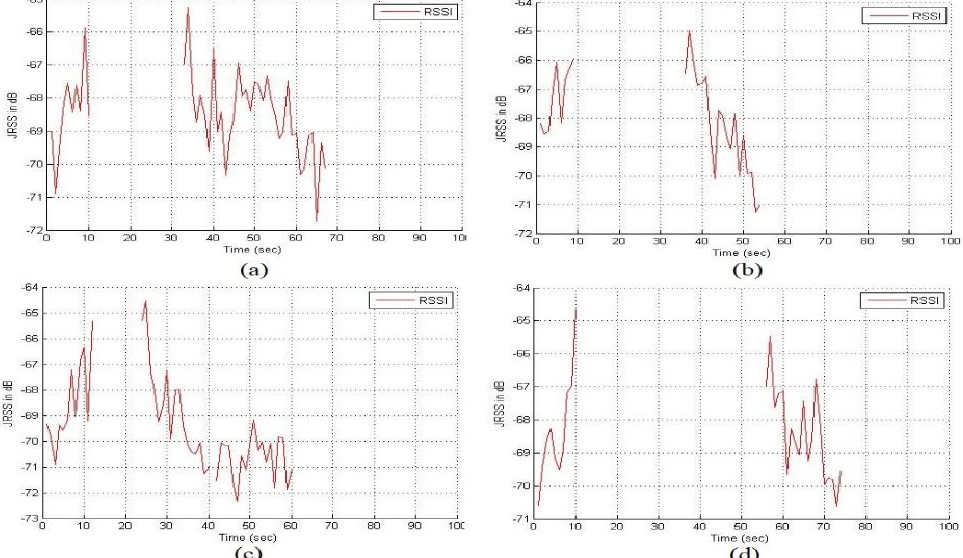
Figure 5. The jammer’s signal received by boundary nodes while the jammer is moving: ( a ) tracking information missing in the period from t = 10 s to t = 23 s; ( b ) tracking information missing in the period from t = 10 s to t = 33 s; ( c ) tracking information missing in the period from t = 10 s to t = 22 s and; and ( d ) tracking information missing in the period from t = 10 s to t = 56 s. This illustration represents boundary nodes affected during jammer movement. In (a), the node detects JRSS at t = 0 and becomes a jammed node in the period from t = 11 s to t = 23 s. In this period, we lost the jammer information. For the same reason, in b, c, and d, the boundary nodes are missing the tracking information while the jammer changes its position. The system stops tracking for the first time when encountering missing data, which t = 11 s shows in Figure 6. For this analysis, defining the boundary nodes while the jammer moving is mandatory. The unjammed nodes received the JRSS as noise, and the SNR decreased based on the amount of JRSS received by the node. Based on this observation, we defined a new threshold for boundary node selection.